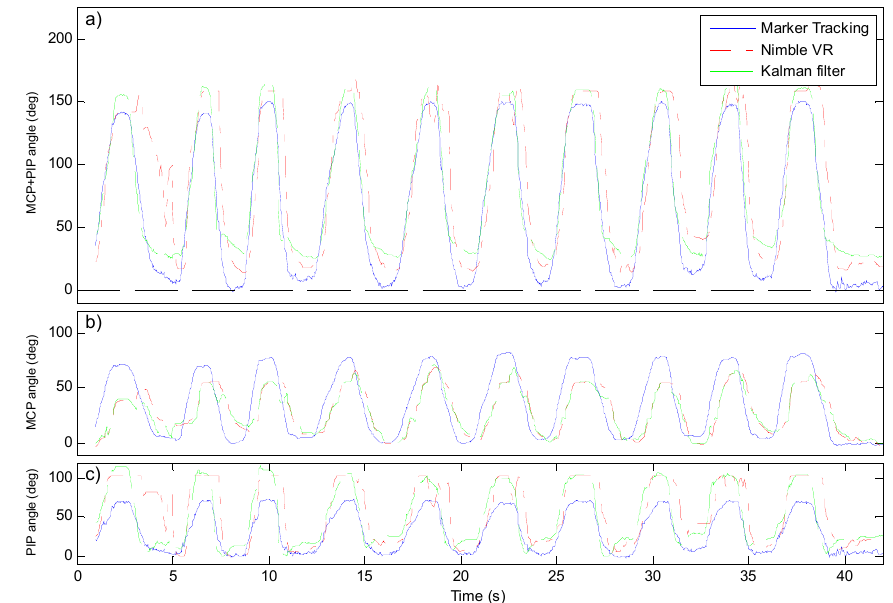
Figure 5 . Active index finger flexion comparison between Marker Tracking, Nimble VR, and Kalman filtered joint angles. Shown data are from the medium sized hand, first measurement session. ( a ) sum of the metacarpophalangeal (MCP) and proximal interphalangeal (PIP) joint angles plotted versus time; ( b ) MCP joint angles versus time; ( c ) PIP joint angles versus time.